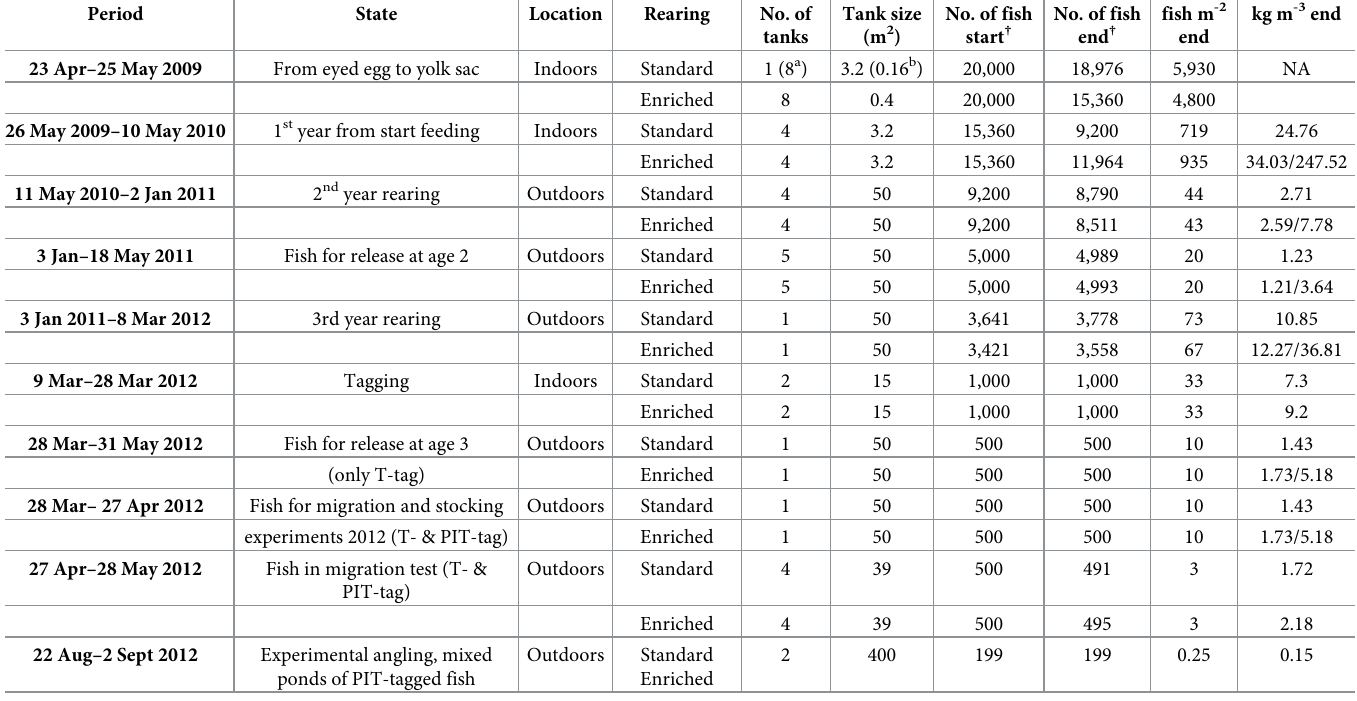
Table 1. Rearing procedure of landlocked